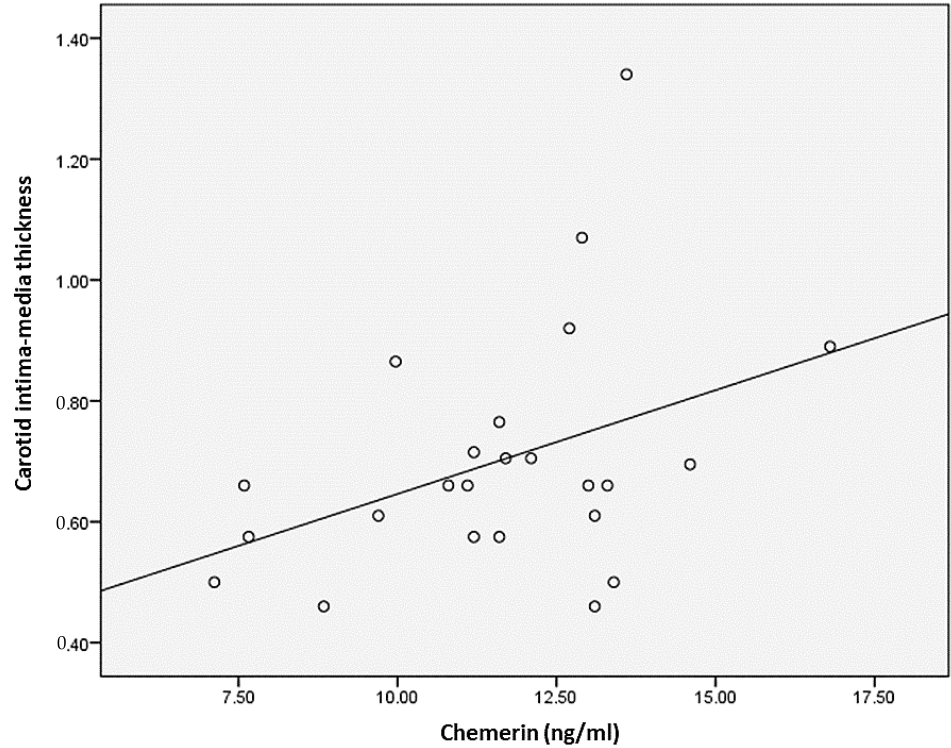
Figure 2. Correlations between serum chemerin levels and carotid intima–media thickness . Table 4. Multiple linear regression models including parameters associated with arterial stiffness .